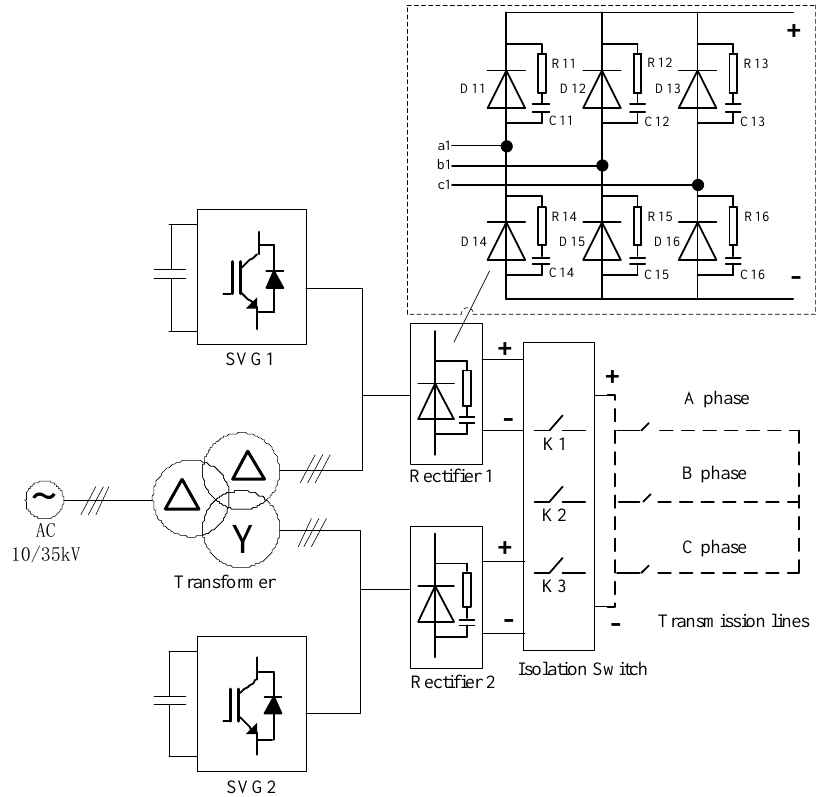
Figure 1. Structure diagram of low-harmonic DC ice-melting device.